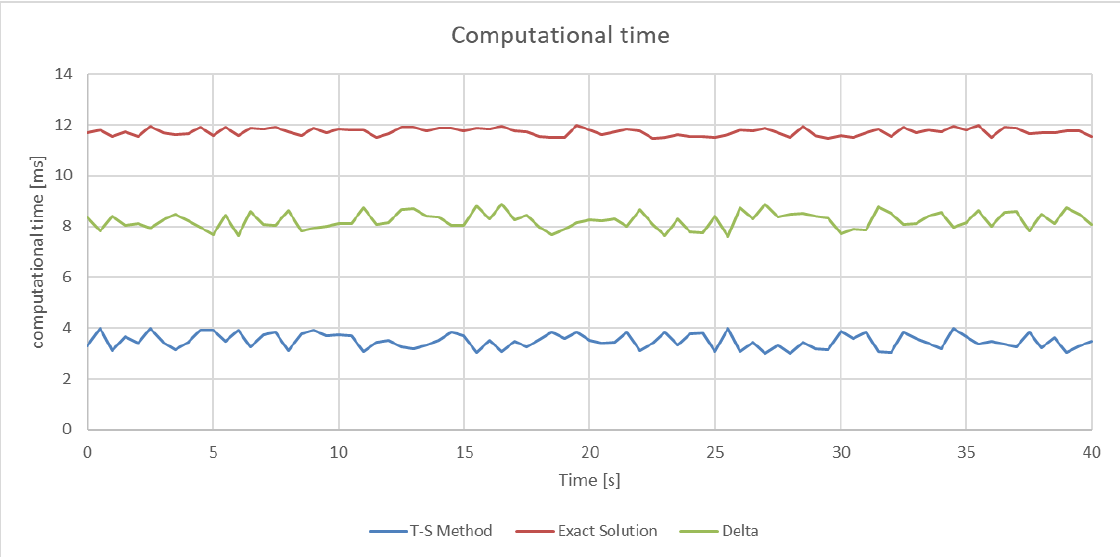
Figure 14. One of the results of the computational time simulation: the T-S method (blue line), the “exact” solution (red line) and the difference (green line).